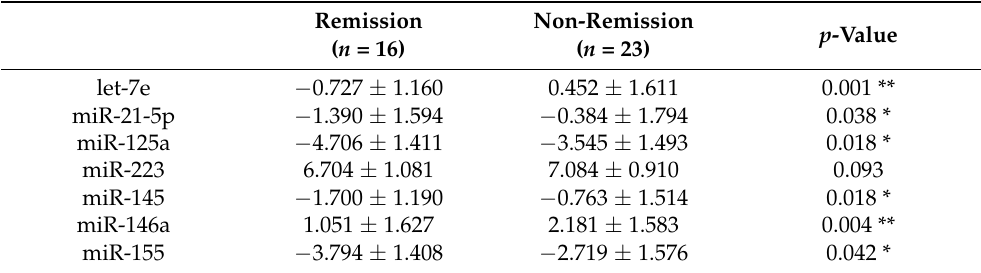
Figure 1. The difference of microRNA between remission and non-remission in patients with major depressive disorder: ( a ) let-7e; ( b ) miR-21-5p; ( c ) miR-223 ( d ) miR-145; ( e ) miR-146a; ( f ) miR-155. Before antidepressants treatment, let-7e, miR-21-5p, miR-145, and miR-146a were significantly lower than non-remission group but were not different from health controls. Antidepressants significantly increased let-7e, miR-21-5p, miR-223, miR-145, miR-146a and miR-155 expression levels.* p < 0.05; ** p < 0.01. Table 4. Difference of exosomal microRNA expression between remission and non-remission at